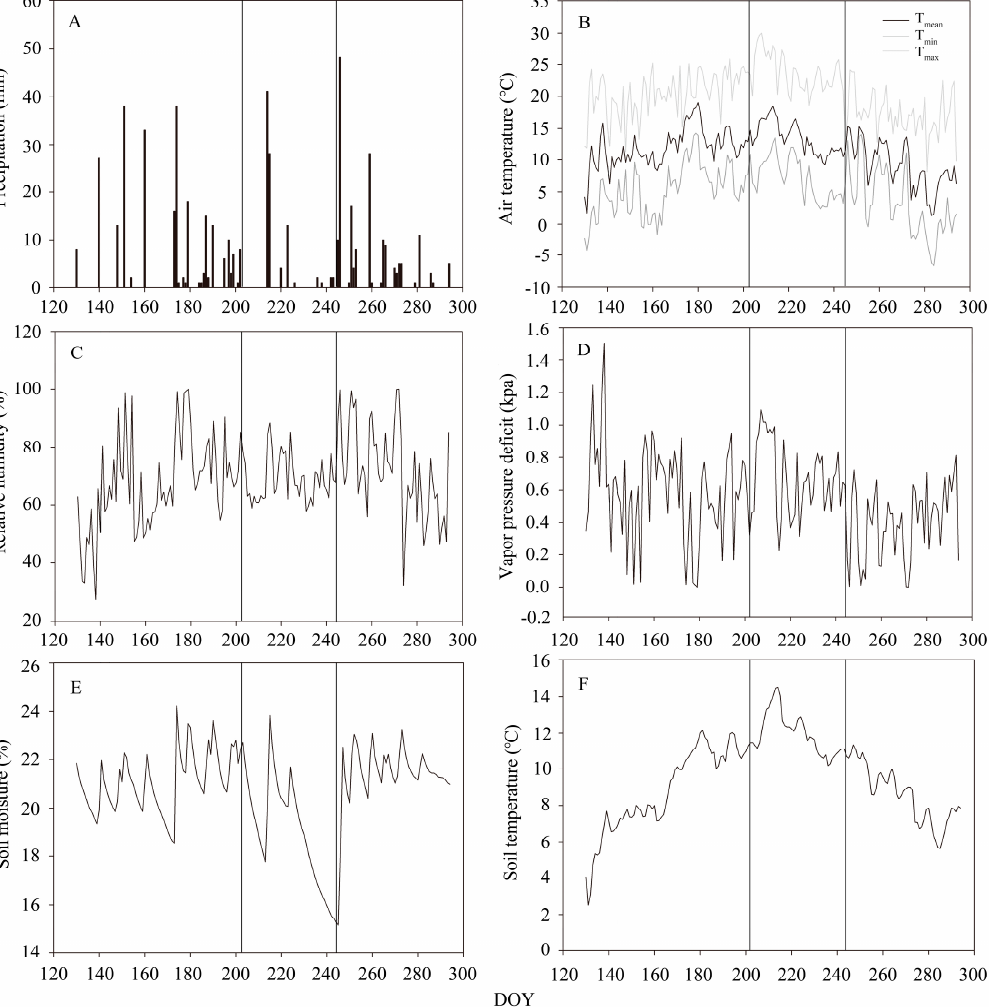
Figure 3. Daily variation of precipitation ( A ), mean and maximum and minimum of air temperature ( B ), relative humidity ( C ), vapor pressure deficit (VPD) ( D ), volumetric soil moisture ( E ), and soil temperature ( F ) during the study period. The vertical lines delimit the three growth stages of stem radius.